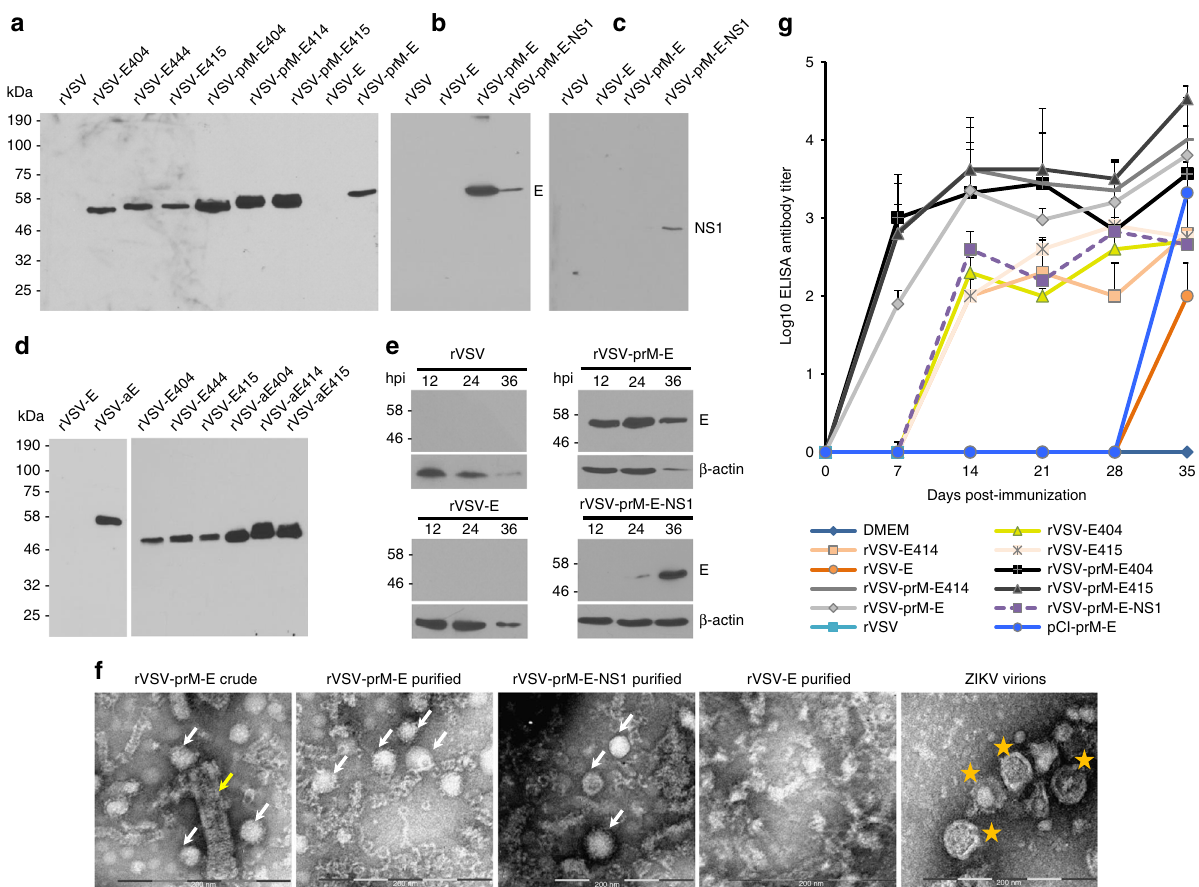
Fig. 1 Recombinant rVSV expressing ZIKV antigens are immunogenic in mice. a Expression of ZIKV E truncations by VSV vector. BSRT7 cells were infected with each recombinant virus expressing ZIKV antigen at an MOI of 3.0. At 16 h post-infection, cells were lysed in 500 μ l of lysis buffer, and 10 μ l of lysate was analyzed by SDS-PAGE and were blotted with anti-ZIKV E protein monoclonal antibody. b Expression of full-length ZIKV E protein by VSV vector. BSRT7 cells were infected with the indicated recombinant virus expressing ZIKV antigen at an MOI of 3.0. Cell lysates were harvested at 16 h post- infection, and analyzed by western blot. c Expression of NS1 protein by VSV vector. Same cell lysates from b were subjected to western blot analysis using anti-ZIKV NS1 antibody. d Comparison of the expression of ZIKV E truncations with or without anchor C signal peptide by VSV vector. BSRT7 cells were infected with each recombinant virus at an MOI of 3.0. Cell lysates were harvested at 16 h post-infection, and analyzed by western blot. e Kinetics of ZIKV E protein expression by the VSV vector. Top panel: BSRT7 cells were infected with each recombinant virus at an MOI of 3.0. Cytoplasmic extracts were harvested at the indicated time points. Equal amounts of total cytoplasmic lysate were analyzed by SDS-PAGE, followed by western blot analysis. Bottom panel: Equal amounts of total cytoplasmic lysate were blotted with anti- β -actin antibody. f Electron microscopy analysis of ZIKV virus-like particles (VLPs). ZIKV VLPs were negatively stained with 1% ammonium molybdate and visualized by a transmission electron microscope. rVSV-prM-E crude indicates a mixture of ZIKV VLPs and VSV virions from supernatant harvested from BSRT7 cells infected by rVSV-prM-E. ZIKV VLPs were further puri fi ed from rVSV- prM-E or rVSV-prM-E-NS1-infected cells. No VLPs were found in rVSV-E. ZIKV Cambodian strain was grown in Vero cells, puri fi ed, and used as a control. The yellow arrow indicates a VSV particle; white arrows indicate ZIKV VLPs; and yellow stars indicate ZIKV virions. g Kinetics of ZIKV-speci fi c ELISA antibody induced by rVSV expressing ZIKV antigens. Groups of fi ve female BALB/c mice were inoculated intranasally with a single dose (10 6 PFU) of rVSV or rVSV expressing ZIKV antigens. For DNA vaccine, mice were immunized intramuscularly with 50 µ g of pCI-prM-E, and boosted with same dose two weeks later. Serum samples were collected weekly and analyzed by ELISA for ZIKV-speci fi c serum IgG Ab. Data are expressed as the geometric mean titers (GMT) of fi ve mice ± standard deviation. Western blots shown are the representatives of three independent